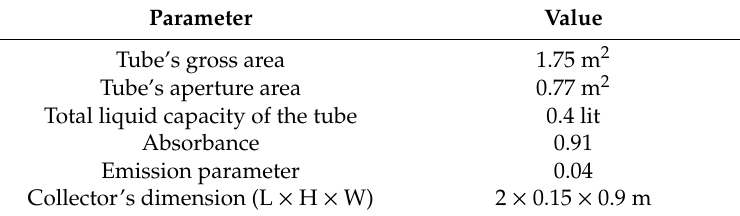
Table 2. Geometrical details of the evacuated tube and the collector used in the present